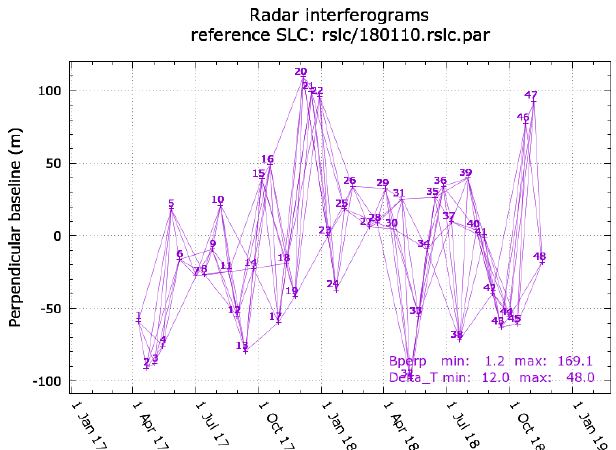
Figure 1. Baseline graph used to calculate interferometric